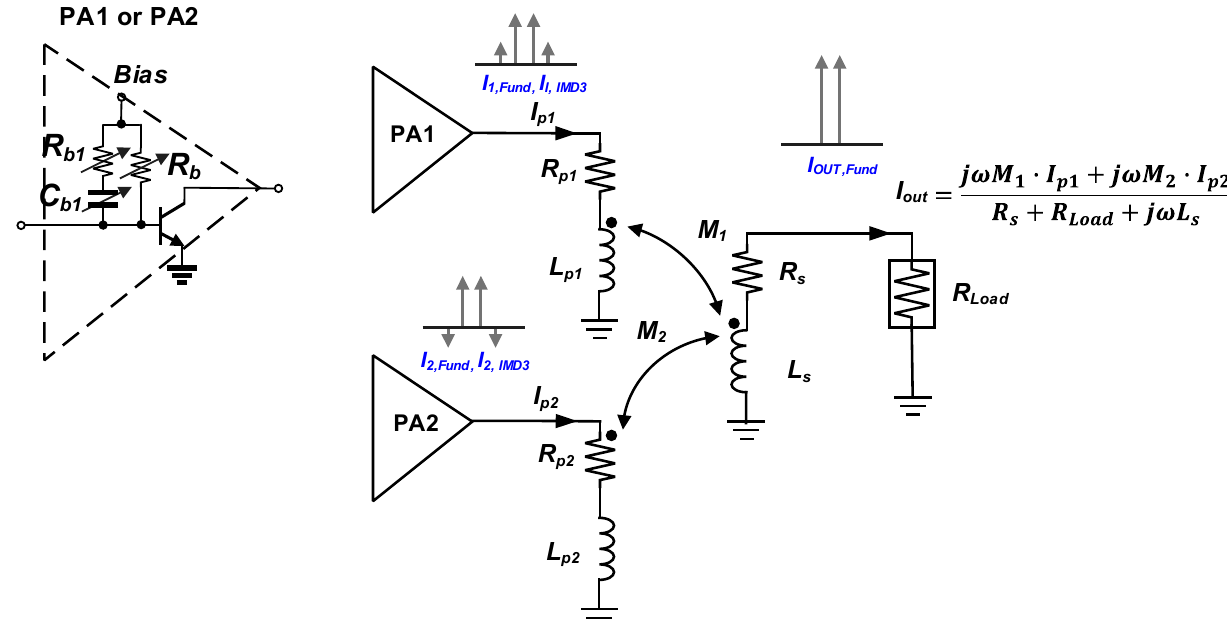
Figure 6. Proposed IMD3 cancellation method using a parallel power-combining transformer.